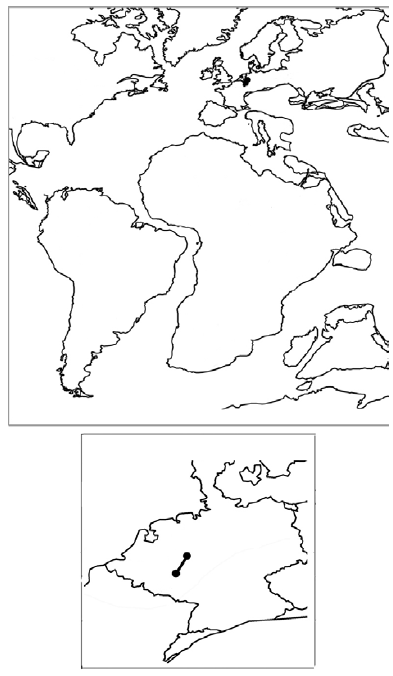
Fig. 3 - Carnian paleogeographic map showing the indi- vi dual track of Diplurus newarki , with a zoom of the occurrences below.